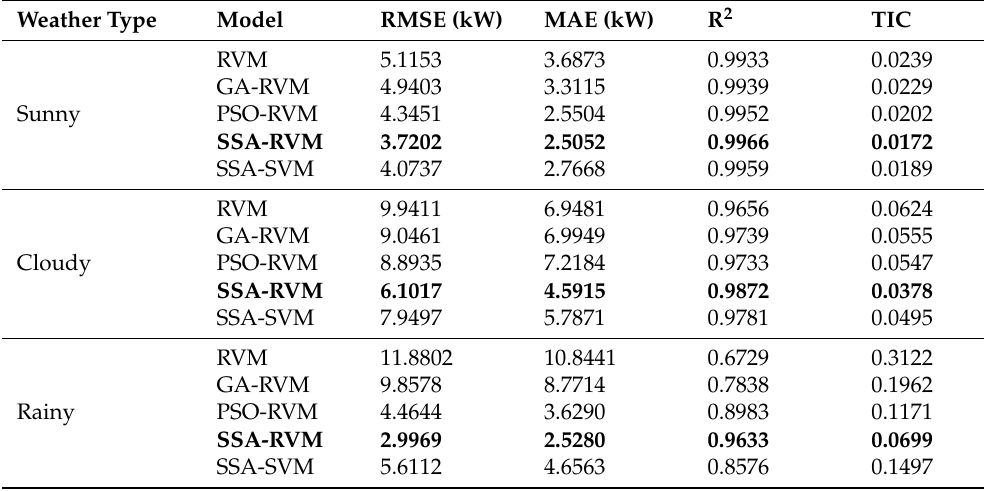
Table 6. Results of evaluation indexes of different methods under different weather types in